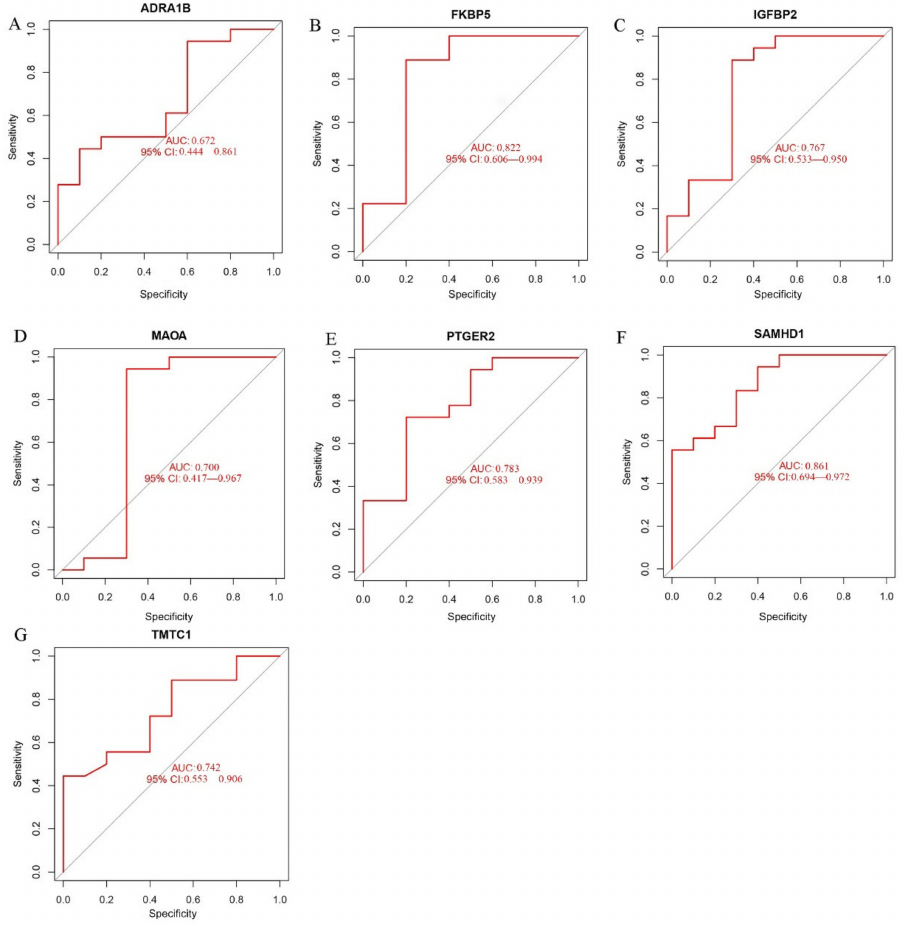
Figure 6. ( A − G ) Receiver operating characteristic (ROC) curves of ADRA1B ( A ), FKBP5 ( B ), IGFBP2 ( C ), MAOA ( D ), PTGER2 ( E ), SAMHD1 ( F ) and TMTC1 ( G ) in test